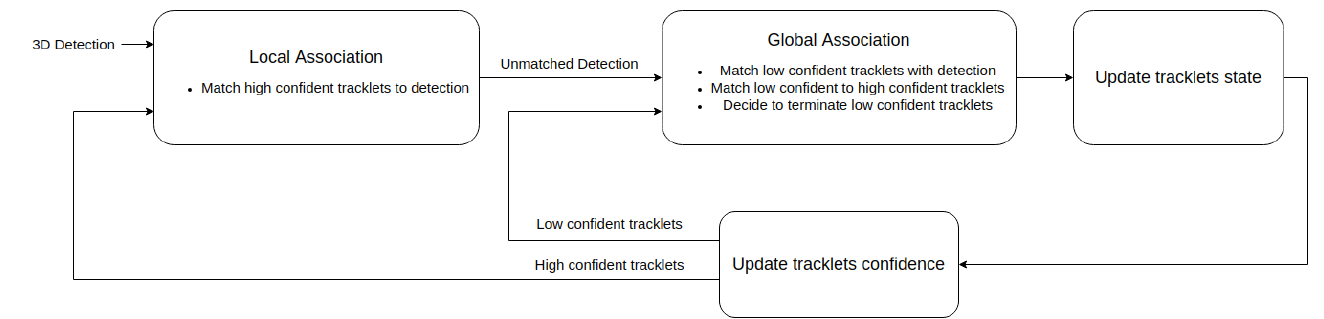
Figure 1. The pipeline of two-stage data association. The first stage — local association establish the correspondences between detections at this time step D t and high-confident tracklets T h low-confident tracklets T i , l with either a high-confident tracklet or a left-over detection, or terminates it.